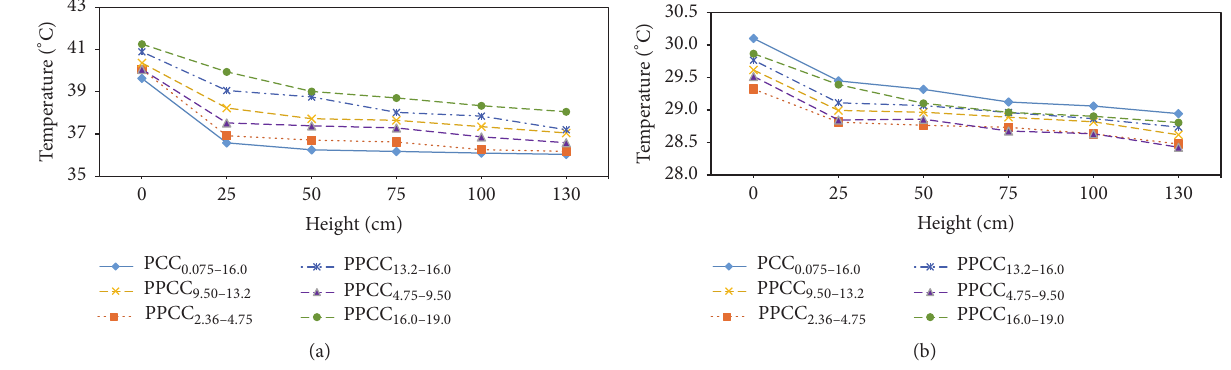
Figure 9: The near-surface air temperature above different concrete: (a) 16:45; (b) 6:45.